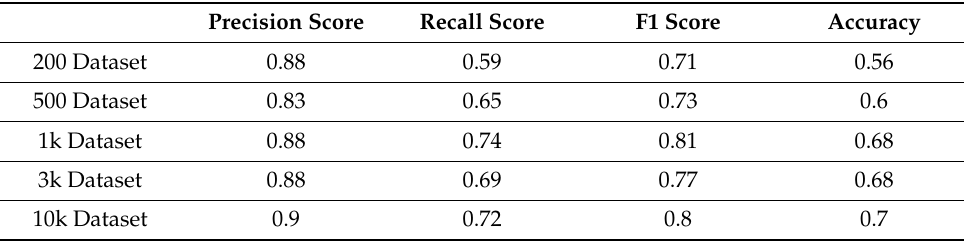
Figure 10. KNN performance results according to the size of the dataset.